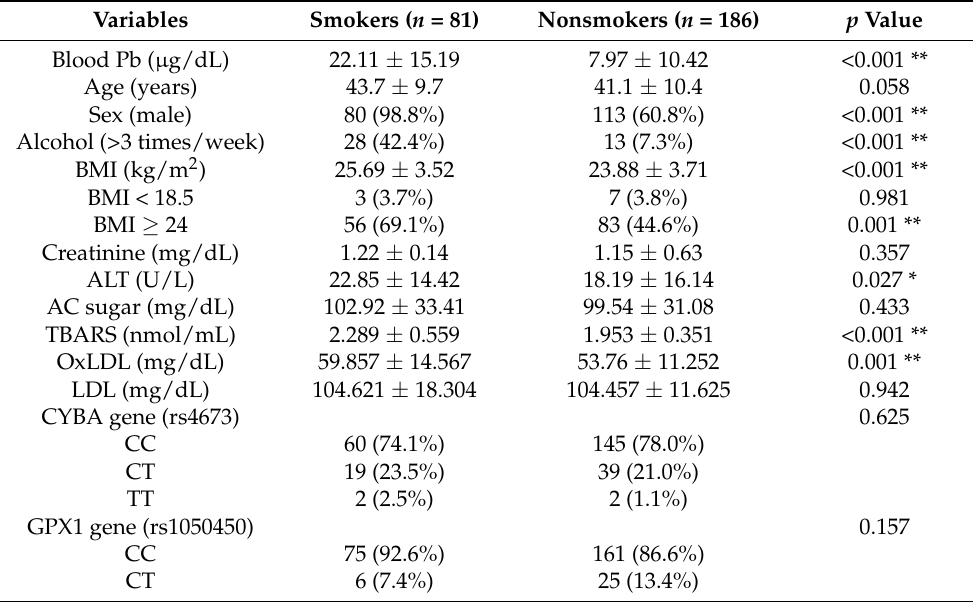
Table 1. Descriptive data of clinical and biochemical by smoking status.